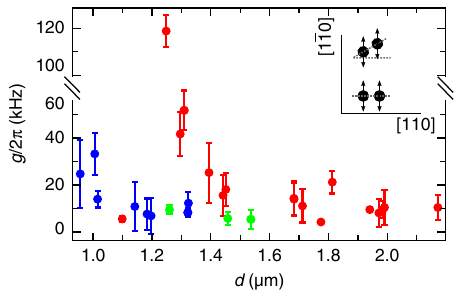
Fig. 4 Measured geometry dependence of coupling strength. Experimentally determined coupling rate g = 2 π of the vertical modes of the two nanopillars over their center-to-center distance d for several samples and pillar pair geometries with r (cid:1) 430 nm & H (cid:1) 7 μ m (red), r (cid:1) 335 nm Fig. 3 Strong coupling. Frequency response measurements of the right & H (cid:1) 7 μ m (blue), r (cid:1) 330 nm & H (cid:1) 8 : 2 μ m (green). Error margins nanopillar under thermal tuning reveals an avoided crossing as an evidence indicate the tolerance of the fi tted coupling rate. The inset shows the for strong coupling. The black line shows a fi t to the data, yielding a level vibration direction for differently oriented pillar pairs (see Supplementary splitting of g = 2 π ¼ 8 : 3 kHz > Δ f (cid:1) 3 : 5 kHz , with the linewidth Δ f . Insets Note 5 for details) show respective scanning electron micrographs of the two modes, indicating a vertical oscillation direction when the resonators are resonantly driven near f (lower inset) and f (upper inset), far from the avoided LV RV crossing